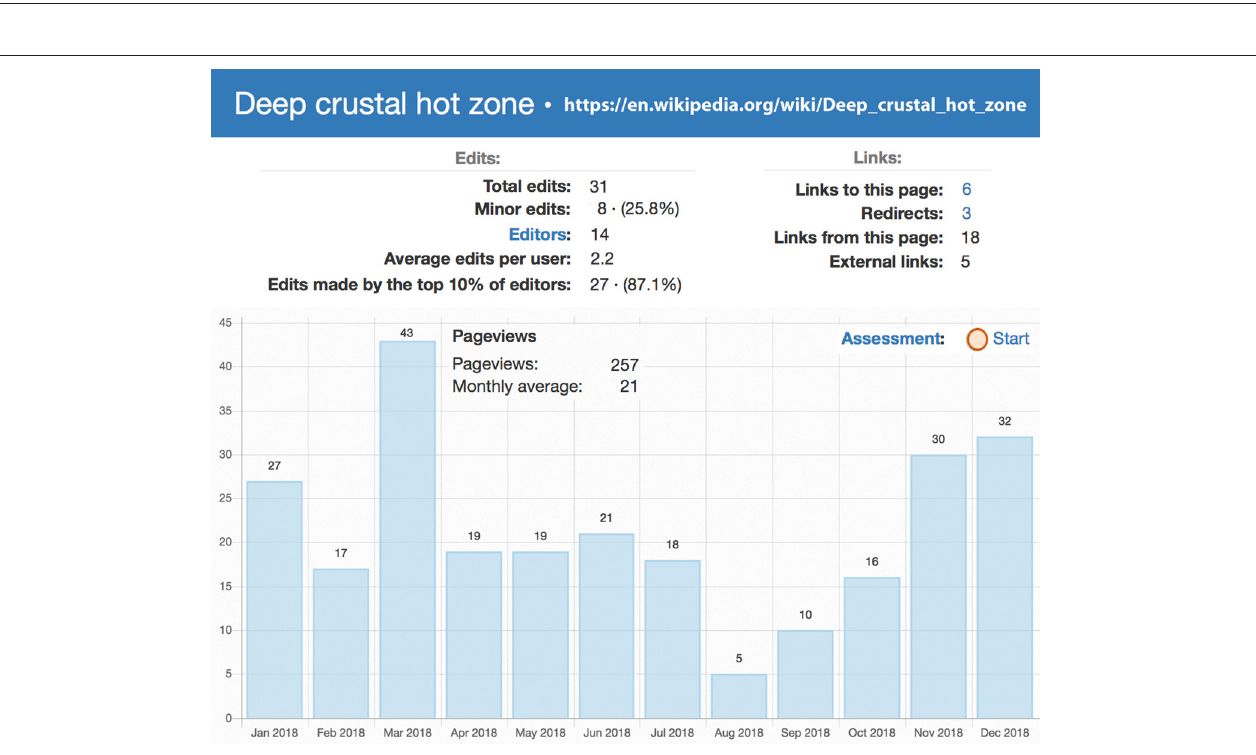
FIGURE 6 | Wikipedia statistics about the newly created page about the “Deep Crustal Hot Zone” (on 01.01.2019; 12 months after publication). https://en.wikipedia. org/wiki/Deep_crustal_hot_zone.